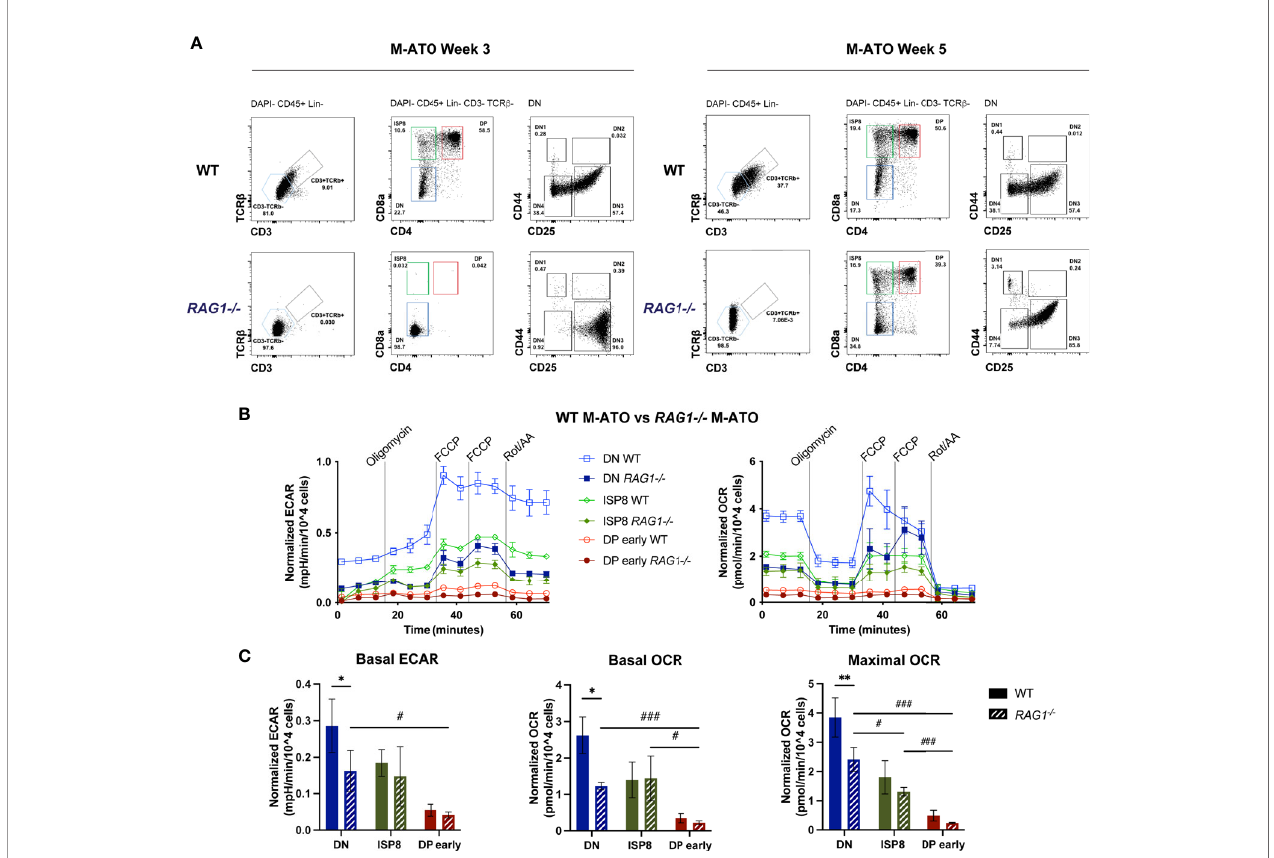
FIGURE 7 | (A) Representative fl ow cytometry analysis of thymocyte populations from Week 3 and 5 M-ATOs derived from WT and Rag1 -/- mouse bone marrow. (B) Extracellular fl ux analyses of thymocyte populations from Week 3 M-ATOs derived from WT or Week 5 M-ATOs derived from Rag1 -/- mouse bone marrow HSPCs. (C) Comparison of basal ECAR, basal OCR, maximal OCR, between thymocyte populations from M-ATOs derived from WT or Rag1 -/- bone marrow HSPCs. (WT: n=6, Rag1 -/- : n=3 independent experiments). (error bars: sd, signi fi cance: multiple t-test p values, comparisons between WT and Rag1 -/- ATO populations denoted by *; comparisons between Rag1 -/- ATO populations denoted by . * or # p < 0.05; ** or ## p < 0.01; *** or ### p <